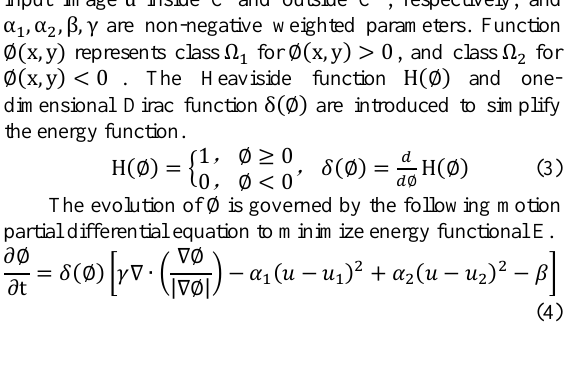
Vector set was obtained by vectorizing (Zhang et al., 2008) binary image generated by segmenting input HSRO image with level-set method. Improved shape curve similarity (ISCS) based registration was employed between and contained in water layer of existing GIS data. Shape curve is proposed in (Chen et al., 2006) as a method of shape representation. In other words, shape curve is a marking diagram generated by angle-distance pattern whereas the corresponding may be ambiguous with concave generation of marking diagram that distance-distance pattern is proposed. Instead of sampling at fixed angle interval, points are picked up at distance interval of where